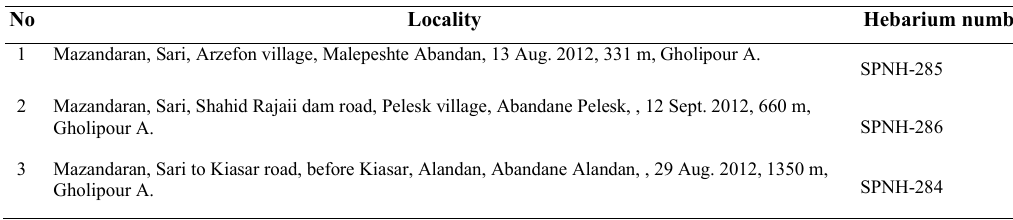
Table 1. Localities and herbarium information of studied populations of A. calamus. No